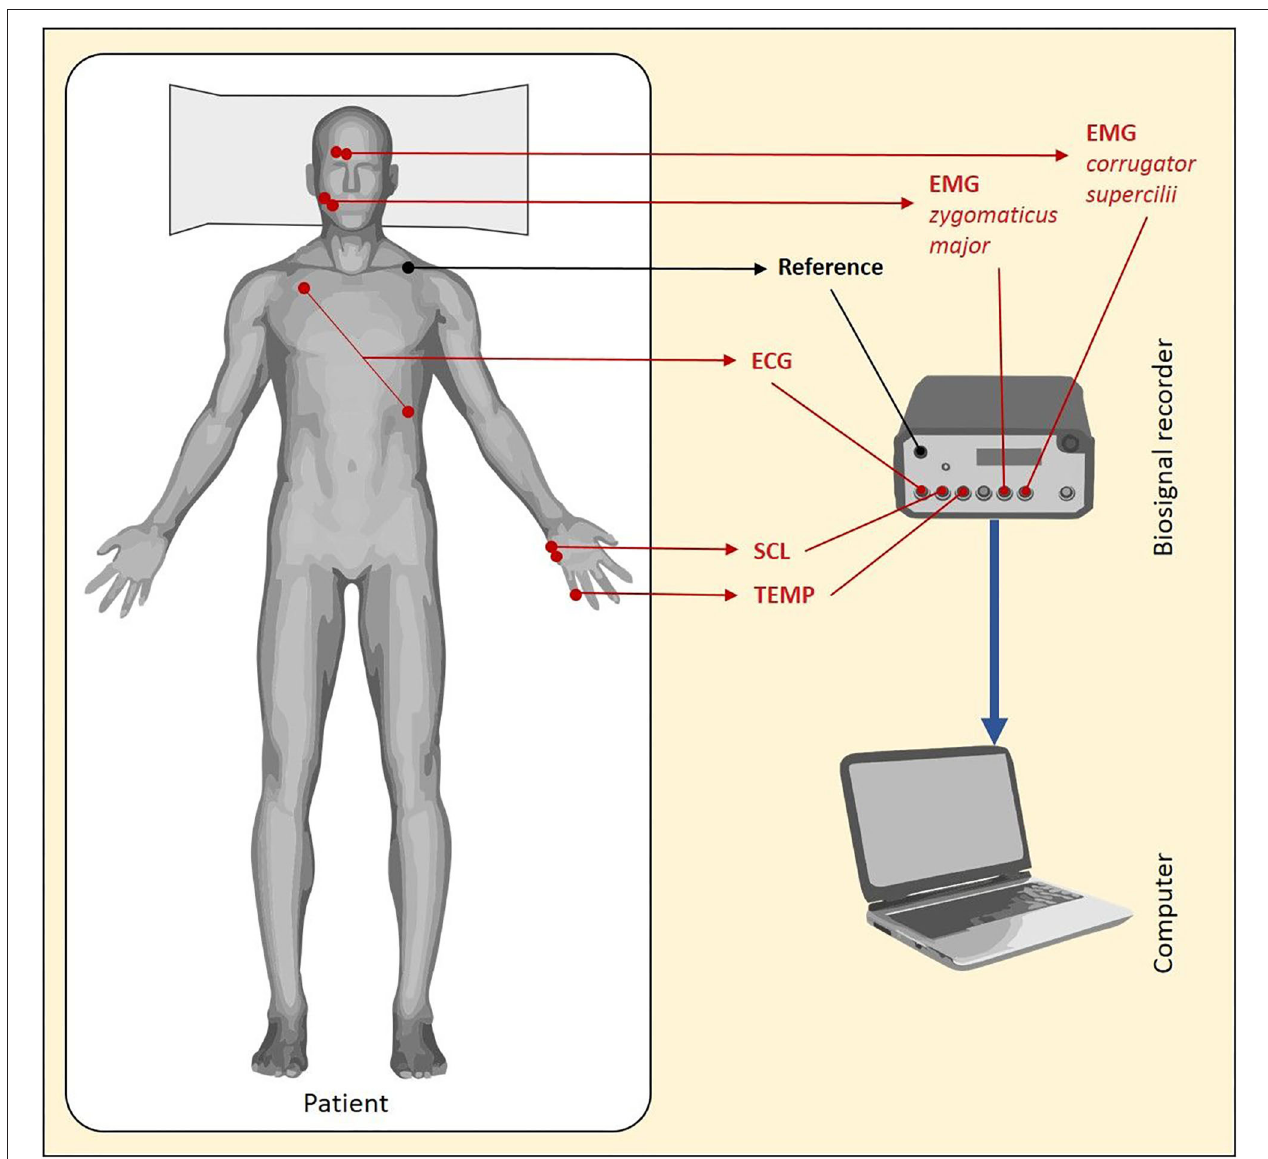
FIGURE 3 | Mean fEMG activity of the facial muscle corrugator supercilii over time during the minute before and after the expression of paralinguistic